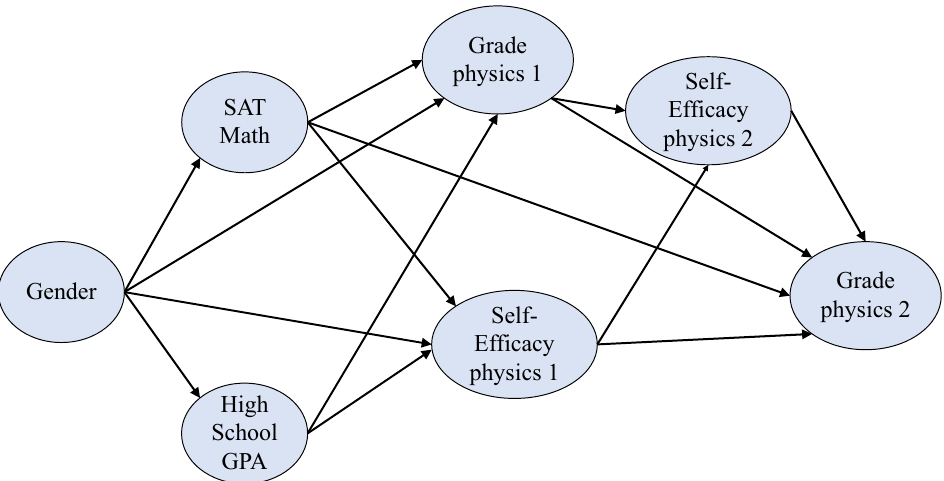
FIG. 1. Schematic representation of the model and how self-efficacy mediates the relation between gender and grade in the physics 2 course for bioscience majors in which women are not underrepresented. From left to right, all possible paths were considered (including the one from gender to grade in physics 2), however, only some of the paths are shown here for